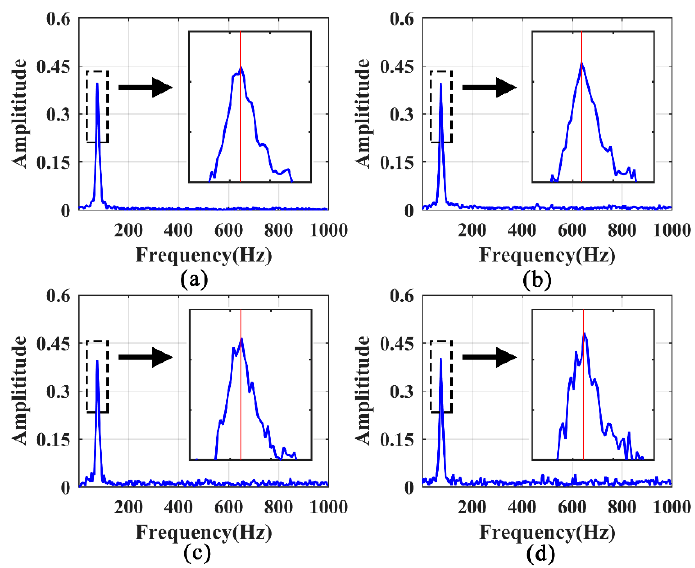
Figure 17. Identification of LPF in frequency spectrums of noisy signals excited by SFE: ( a ) σ = 0.05;